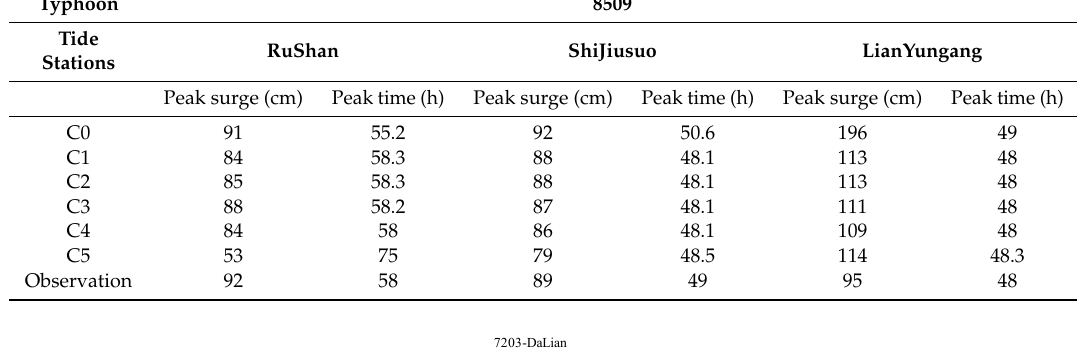
Table 5. The peak surge and peak time between simulation and observation of storm surge levels at three tide stations during Typhoon 8509.